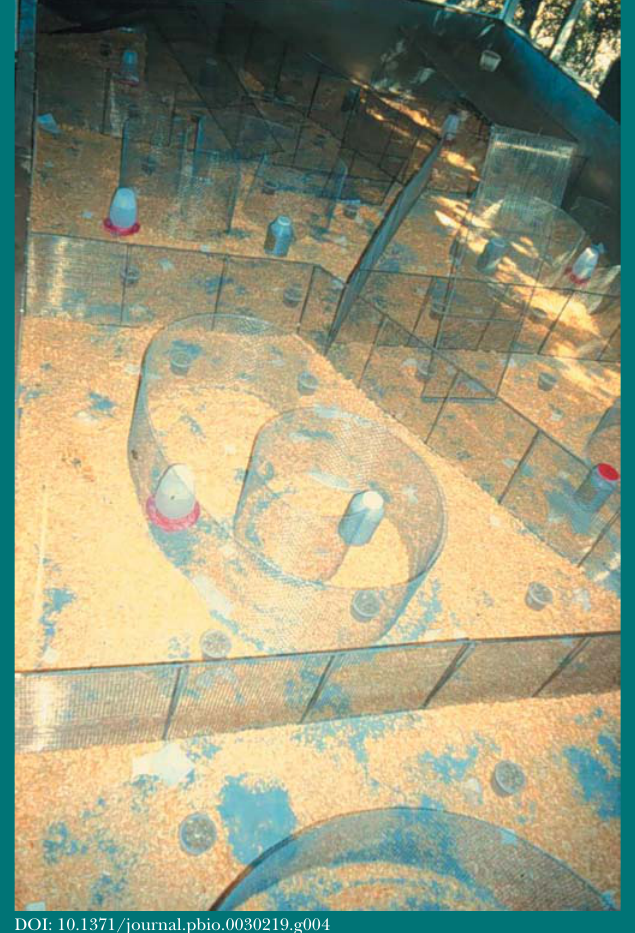
Figure 4. Setting the Stage in Ecology—The Phenotron (Image: Wayne